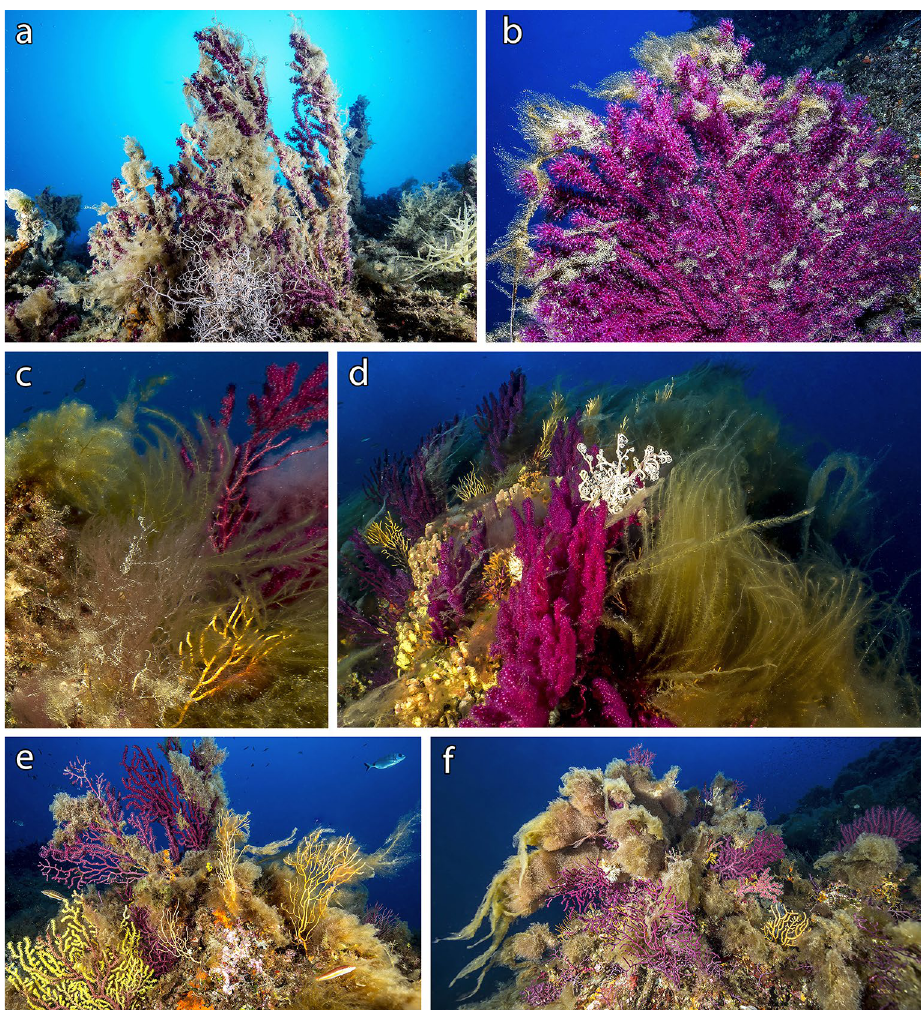
Figure 9. Macroalgae overgrowth and epibiosis on gorgonians. Tuscan Archipelago: ( a ) Off Argentario (35 m depth); ( b ) Off Giannutri (40 m depth); ( c – d ) Mezzocanale Shoal (45–50 m depth) with abundant presence of large thalli of Sporochnus pedunculatus . Tavolara Marine Protected Area: ( e – f ) Papa Shoal (35–40 m